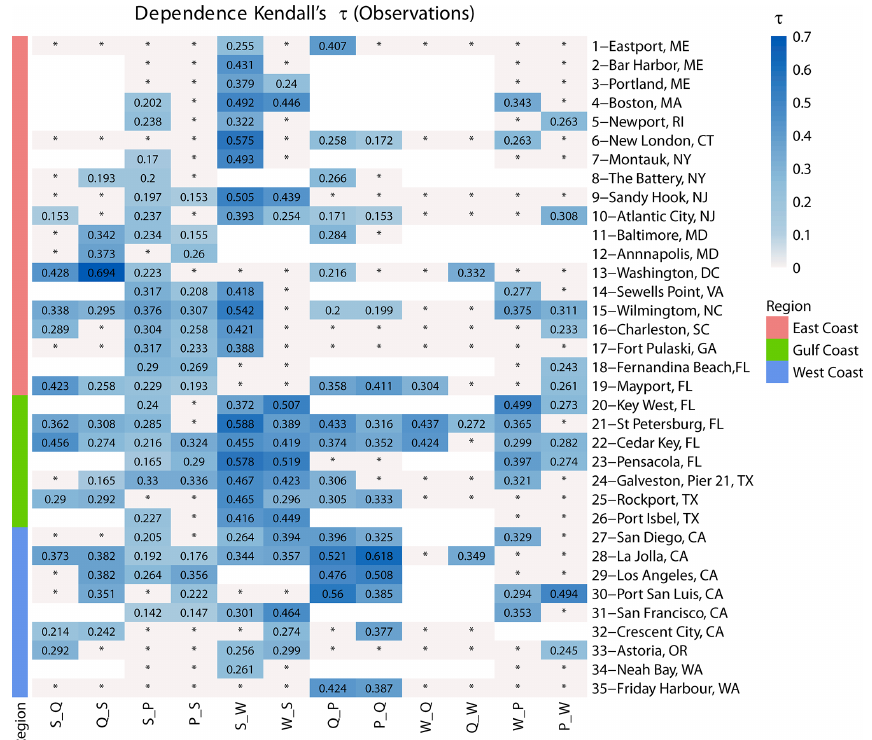
Figure 3. Dependence between different pairs of flooding drivers based on Kendall’s τ and two-way sampling using annual maxima. Sites are grouped into locations on the East, Gulf, and West coasts (see colours on the left and in the legend). The blue colour bar denotes dependence strength, blank squares indicate that data for the particular pair did not exist, or that the number of overlapping years was less than 20, and squares with an asterisk ( ∗ ) indicate that correlation is not